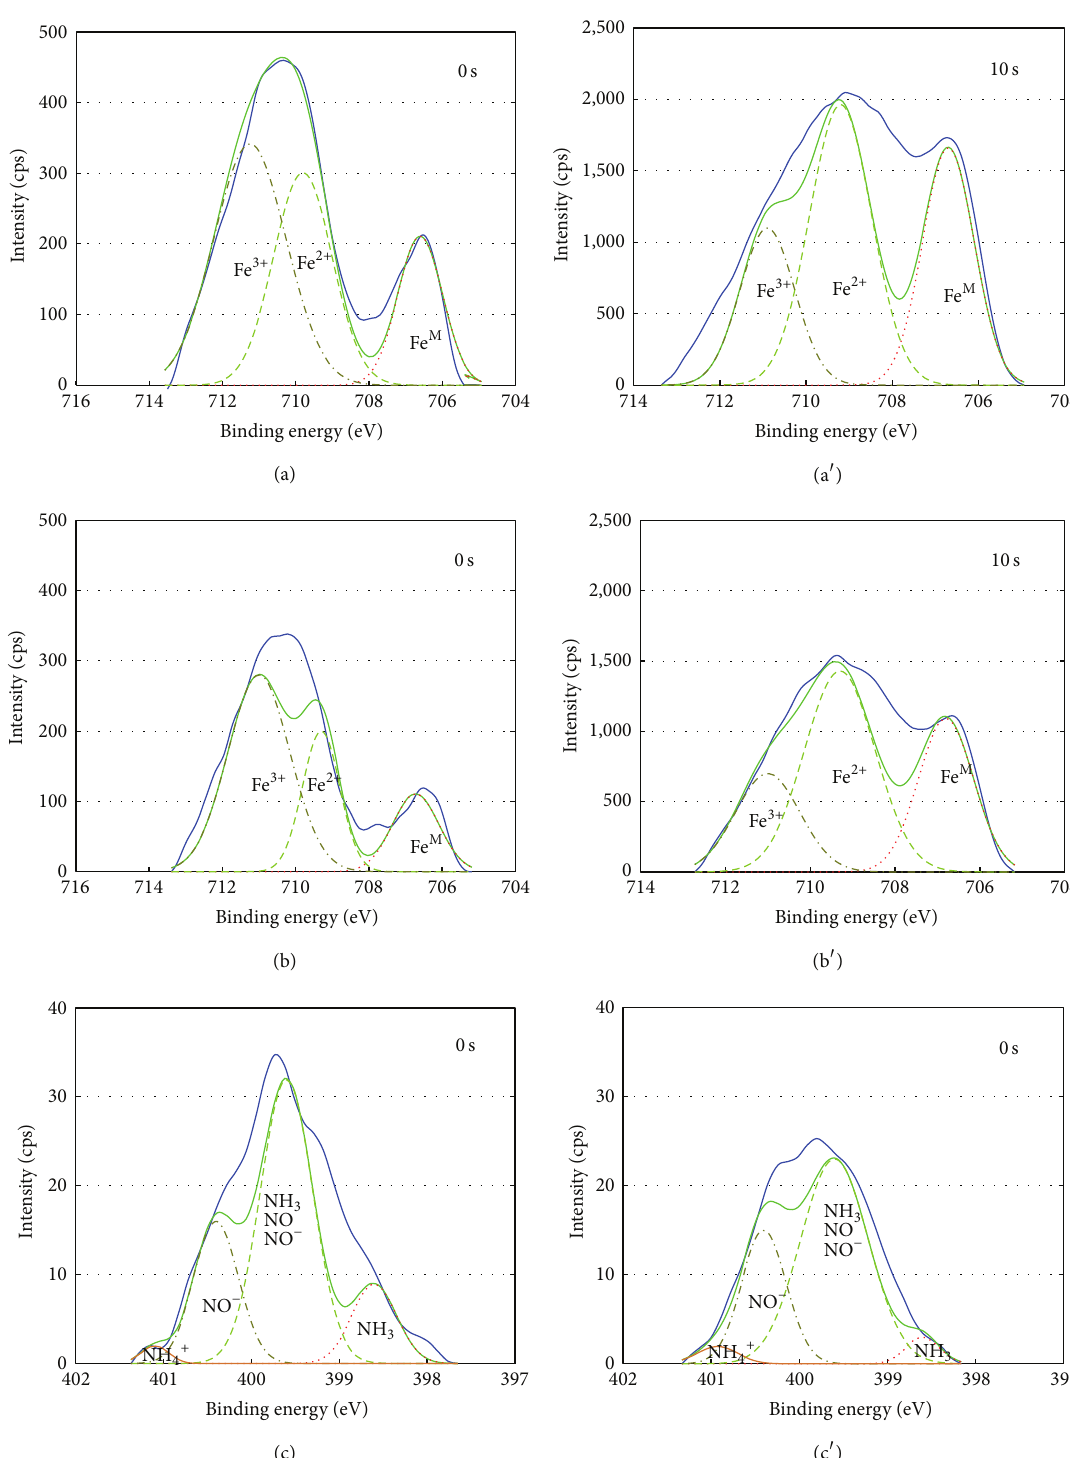
Figure 14: Deconvolution of the chemical species determined by XPS on the surface of (a, a 󸀠 , c) carbon steel passivated in 1,000ppm NaNO 2 and (b, b 󸀠 , c 󸀠 ) ductile cast iron passivated in 100,000 ppm NaNO 2 ; (a) and (a 󸀠 ) Fe 2p, (b) and (b 󸀠 ) Fe 2p, and (c) and (c 󸀠 ) N